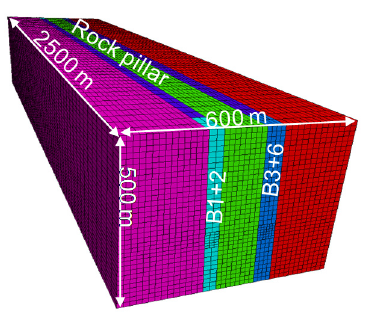
Figure 12. Model used for simulation.